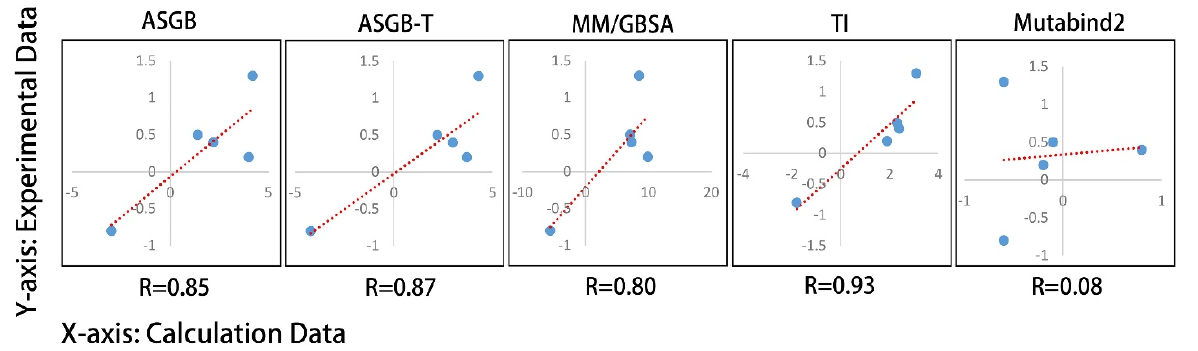
Figure 4. Scatter diagram of experimental and calculated values of various methods. The red dotted line is the fitting line between calculated and experimental values. The R values represent the linear correlation coefficient between the experimental and calculated values of different methods.